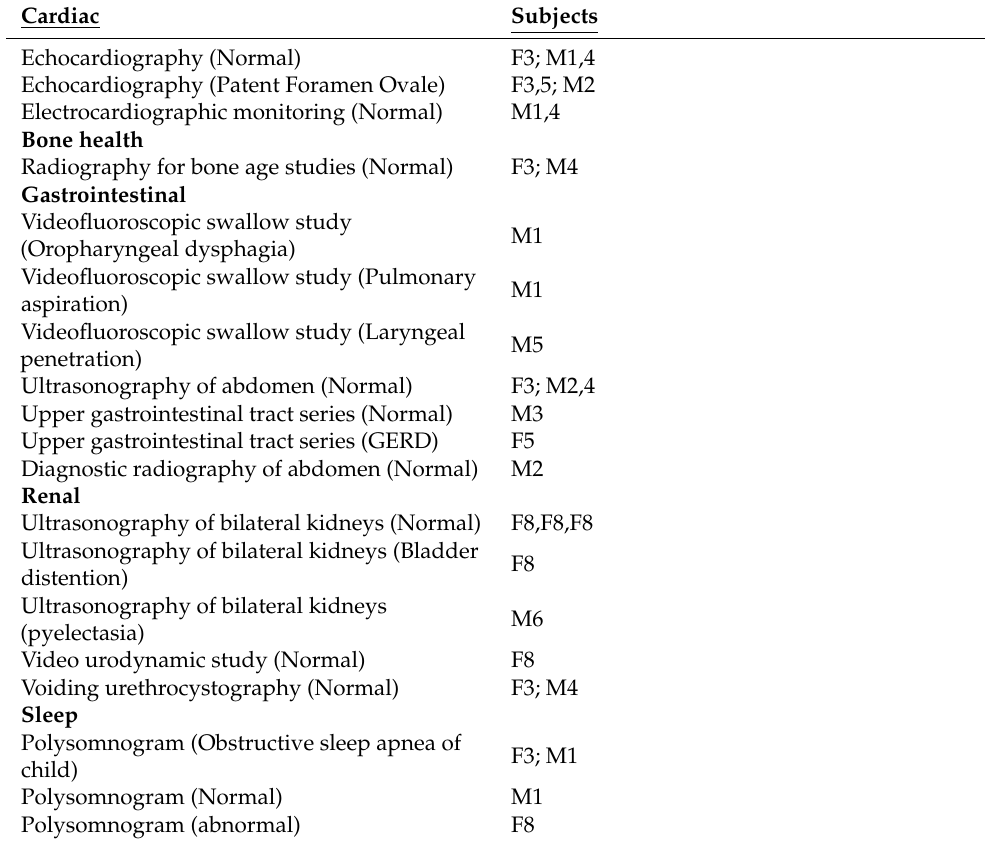
Table 3. Non-neurologic studies performed and results. Each study performed is listed; if a patient is listed more than once that represents a separate procedure. Study findings are simplified and listed within the parentheses. GERD-gastrointestinal esophageal reflux disease.